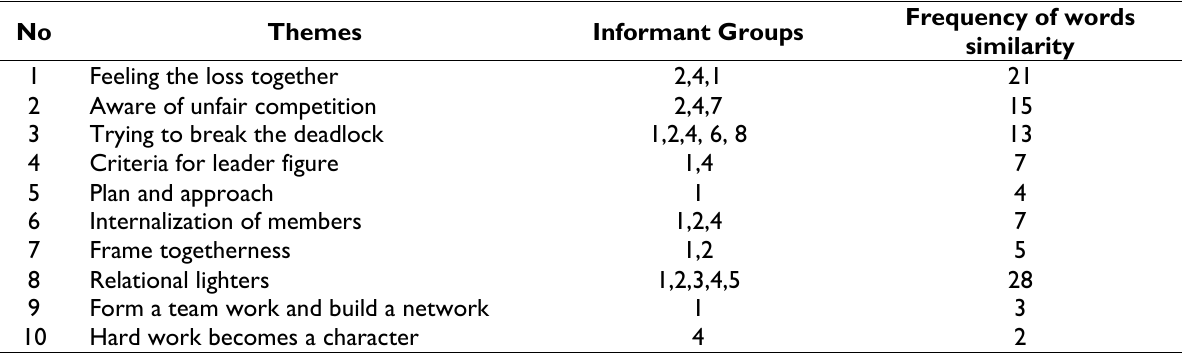
Table 1. Data Structure of Theme